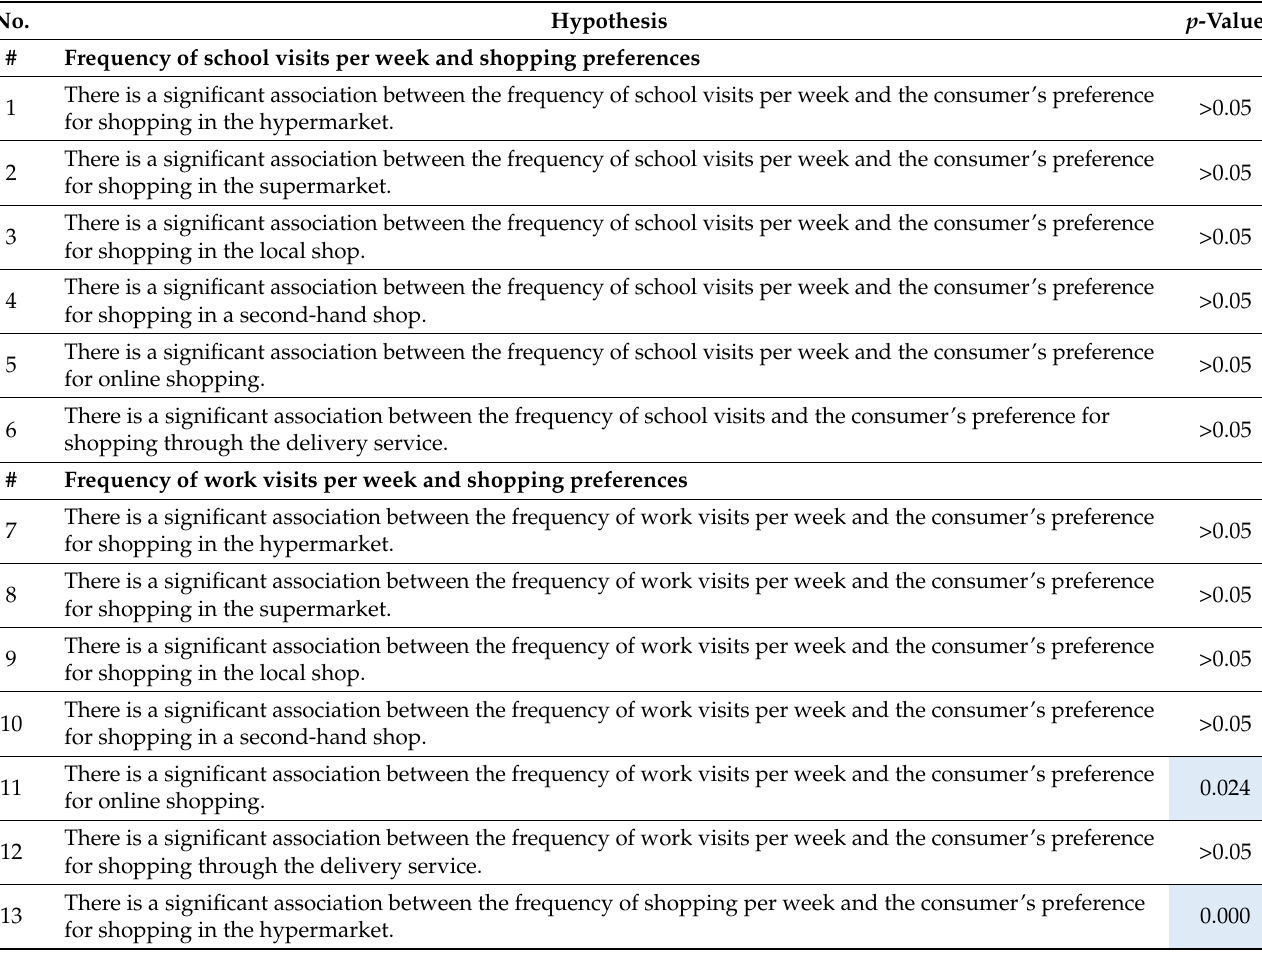
Table 3. Hypothesis summary with statistical significance divided into six